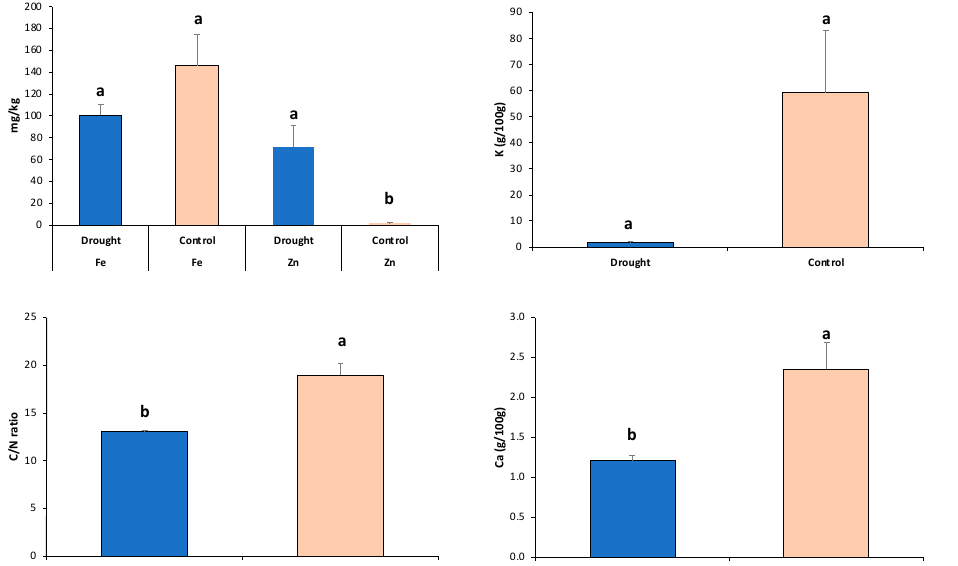
Bold values denote statistical significance at the p < 0.05 level.